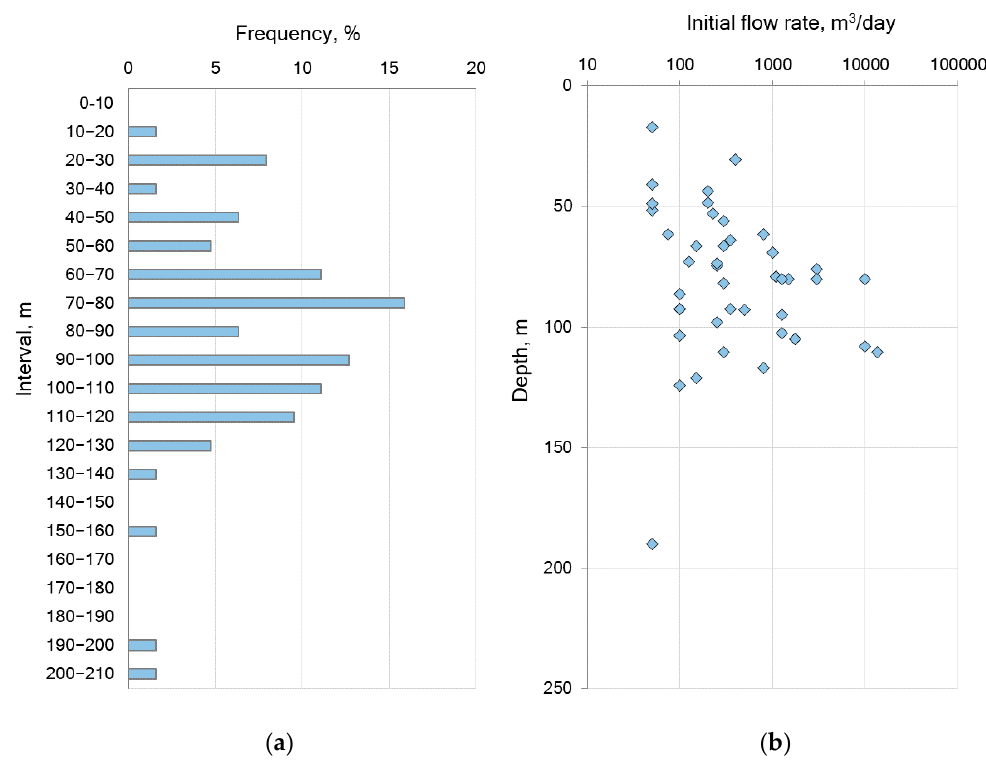
Figure 10. Frequency, as the number of gas shows, per 10 m depth interval ( a ) and initial flow rate ( b ) of gas in permafrost within the Bovanenkovo field.